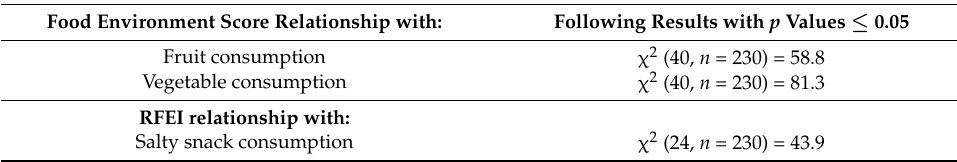
Table 3. Association between Food Environment Score, RFEI, and Consumption of Individual Food